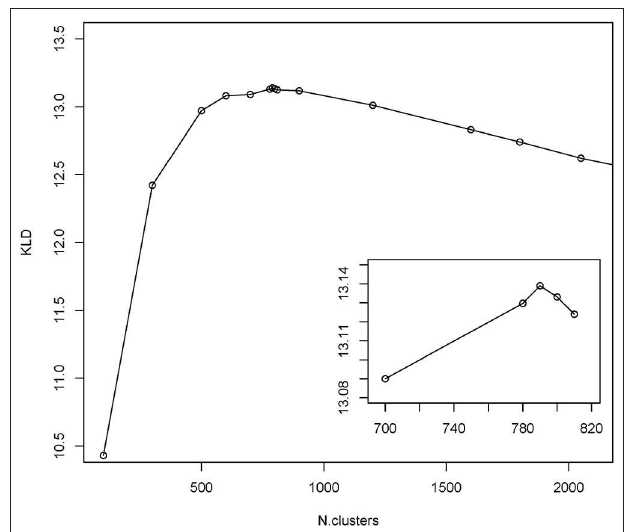
FIGURE 3 | Results from GibbsCluster of the mimotopes. Different predefined numbers of clusters were screened for the quality of clustering as measured by Kullback–Leibler divergence (KLD). The inset shows the amplified part around the peak KLD values.